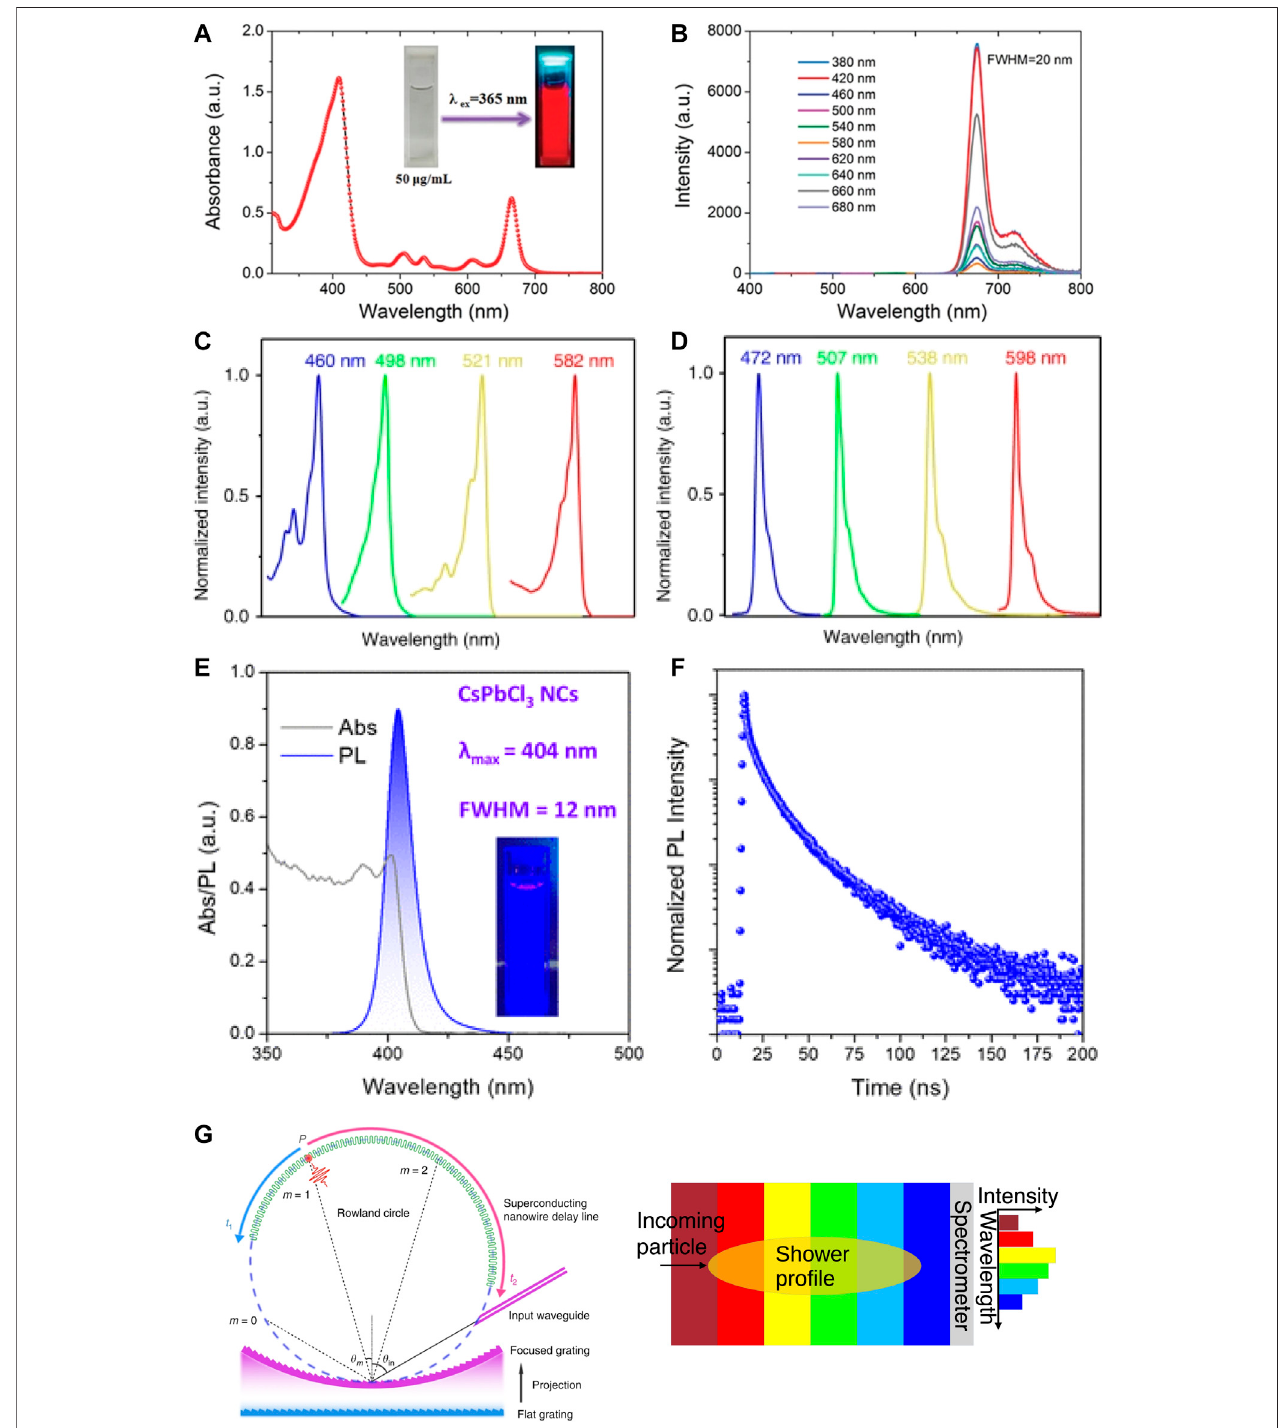
FIGURE 2 | Absorption and photoluminescence (PL) emission spectra of selected narrow bandwidth quantum dot emitters. Top row: Carbonized polymer dots (CPD ’ s):absorptionandemissionspectra[53].Secondrow:triangularCarbonquantumdots.ThenormalizedUV-visabsorption (C) andphotoluminescence (D) spectra of B-, G-, Y-, and R-NBE-T-CQDs, respectively [54]. Third row: CsPbCl3 nanocrystals. (E) optical absorption and PL spectra (excitation wavelength 350 nm) (inset: corresponding photograph under UV light), and (F) time-resolved photoluminescence (TRPL) decay curve of the synthesized PhPOCl 2 -based CsPbCl 3 nanocrystals [55]. Bottom row: (G) Sketch of a compact nanowire-based spectrometer [56] and (H) of the overall scheme for the positioning of the different emission- wavelengthspeci fi cnandots.Thehistogram totheright corresponds tothe spectral intensity, and thus thedepthpro fi le, ofthe showerinitiated bytheincoming particle. Figures by